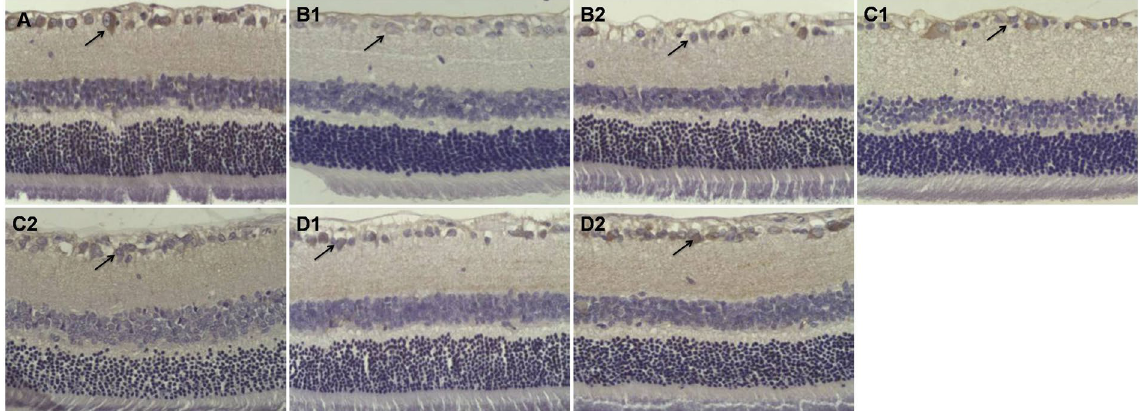
Figure 4. Thy-1-positive cells (the number of surviving RGCs) in the retina. ( A ) The number of Thy-1- positive cells was normal in Group A (25.2 ± 3.4 n/HPF) (arrow). Immunohistochemical staining 200 × . ( B ) The number of Thy-1-positive cells was lower mainly in the ganglion cell layer in Group B (13.3 ± 1.9 n/ HPF; p < 0.05) (arrow). Immunohistochemical staining 200 × . ( C , D ) The number of Thy-1-positive cells was higher in Groups C and D than in Group B ( p < 0.05) (arrow); the number was particularly higher in Group D